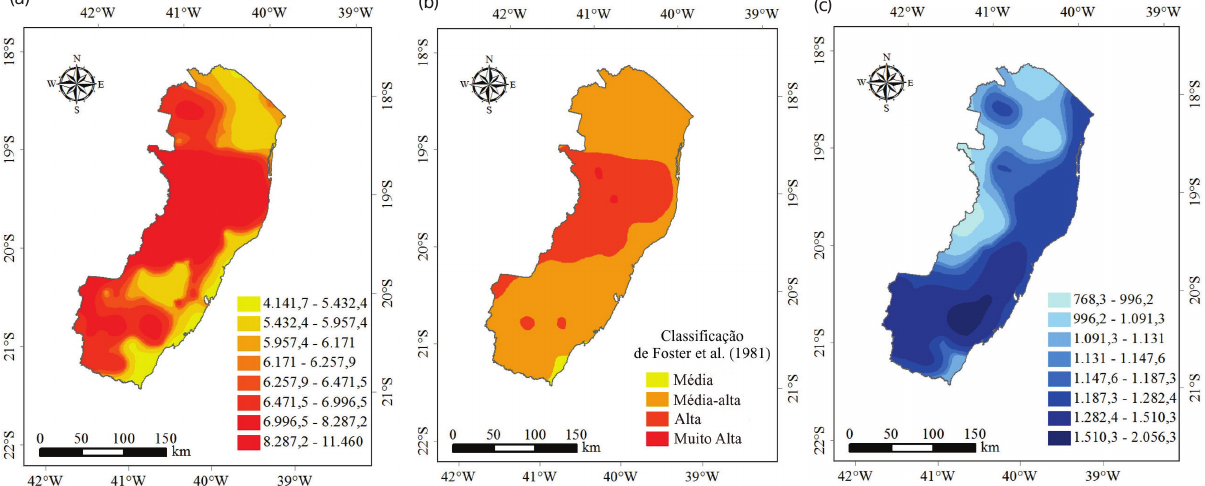
Figura 7. Mapas de erosividade anual (MJ mm ha -1 h -1 ano -1 ) (a), de erosividade anual conforme classificação de Foster et al. (1981) (b) e precipitação anual (mm) (c), para o Estado do Espírito